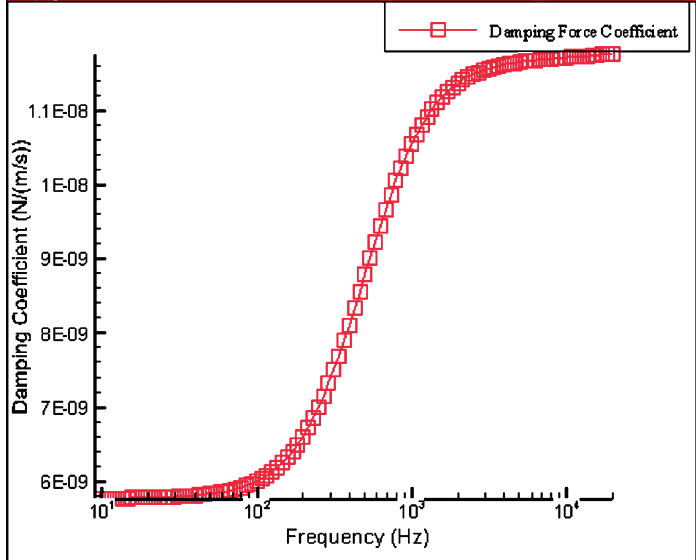
Figure 5. Simulation of damping force coefficient over the operational frequency